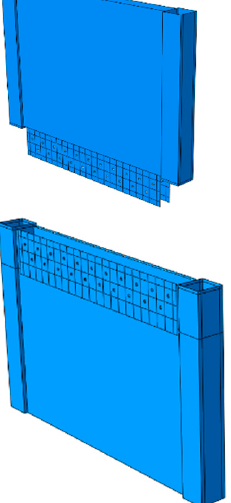
Figure 5. Diagrammatic drawing of simulation assembly 1.